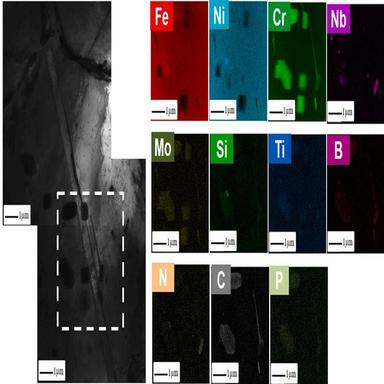
BF TEM and Chemical Maps of Alloy 709 after 800 ◦C and 70 MPa Creep Test showing Precipitates on Coherent Twin Boundary and formation of M6X (Cr6C).